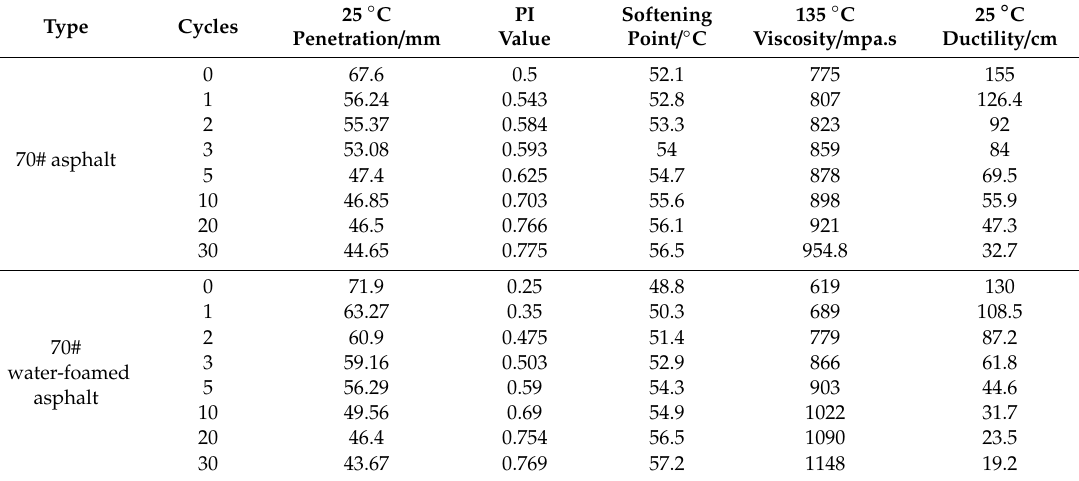
Table 3. Conventional physical properties test results of foamed and non-foamed asphalt with freeze–thaw (F–T)